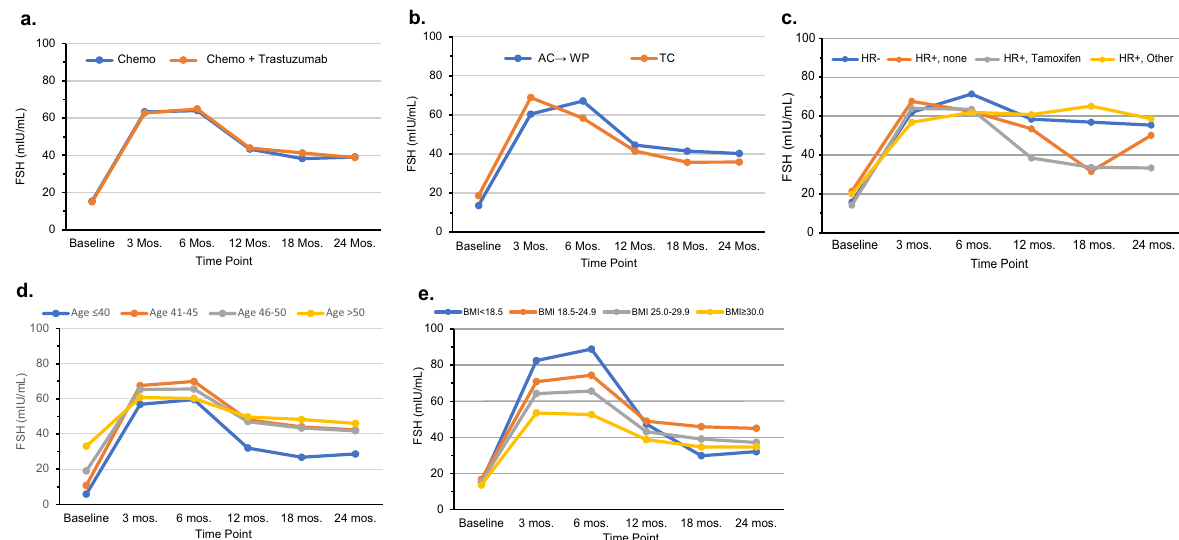
Fig. 3 Mean Follicle-stimulating Hormone (FSH) Levels Respectively over Time in NSABP B-47. Levels are presented by: treatment group ( a ), chemotherapy regimen ( b ), HR status/endocrine therapy use ( c ), age group ( d ), and BMI ( e ). A higher FSH level indicates a late premenopausal/postmenopausal range. Adjusted least-square means for time points 3 months and beyond were obtained from a mixed model for repeated measures analysis of the FSH level. The model includes age, FSH baseline level, the variable of interest, time, and variable- by-time